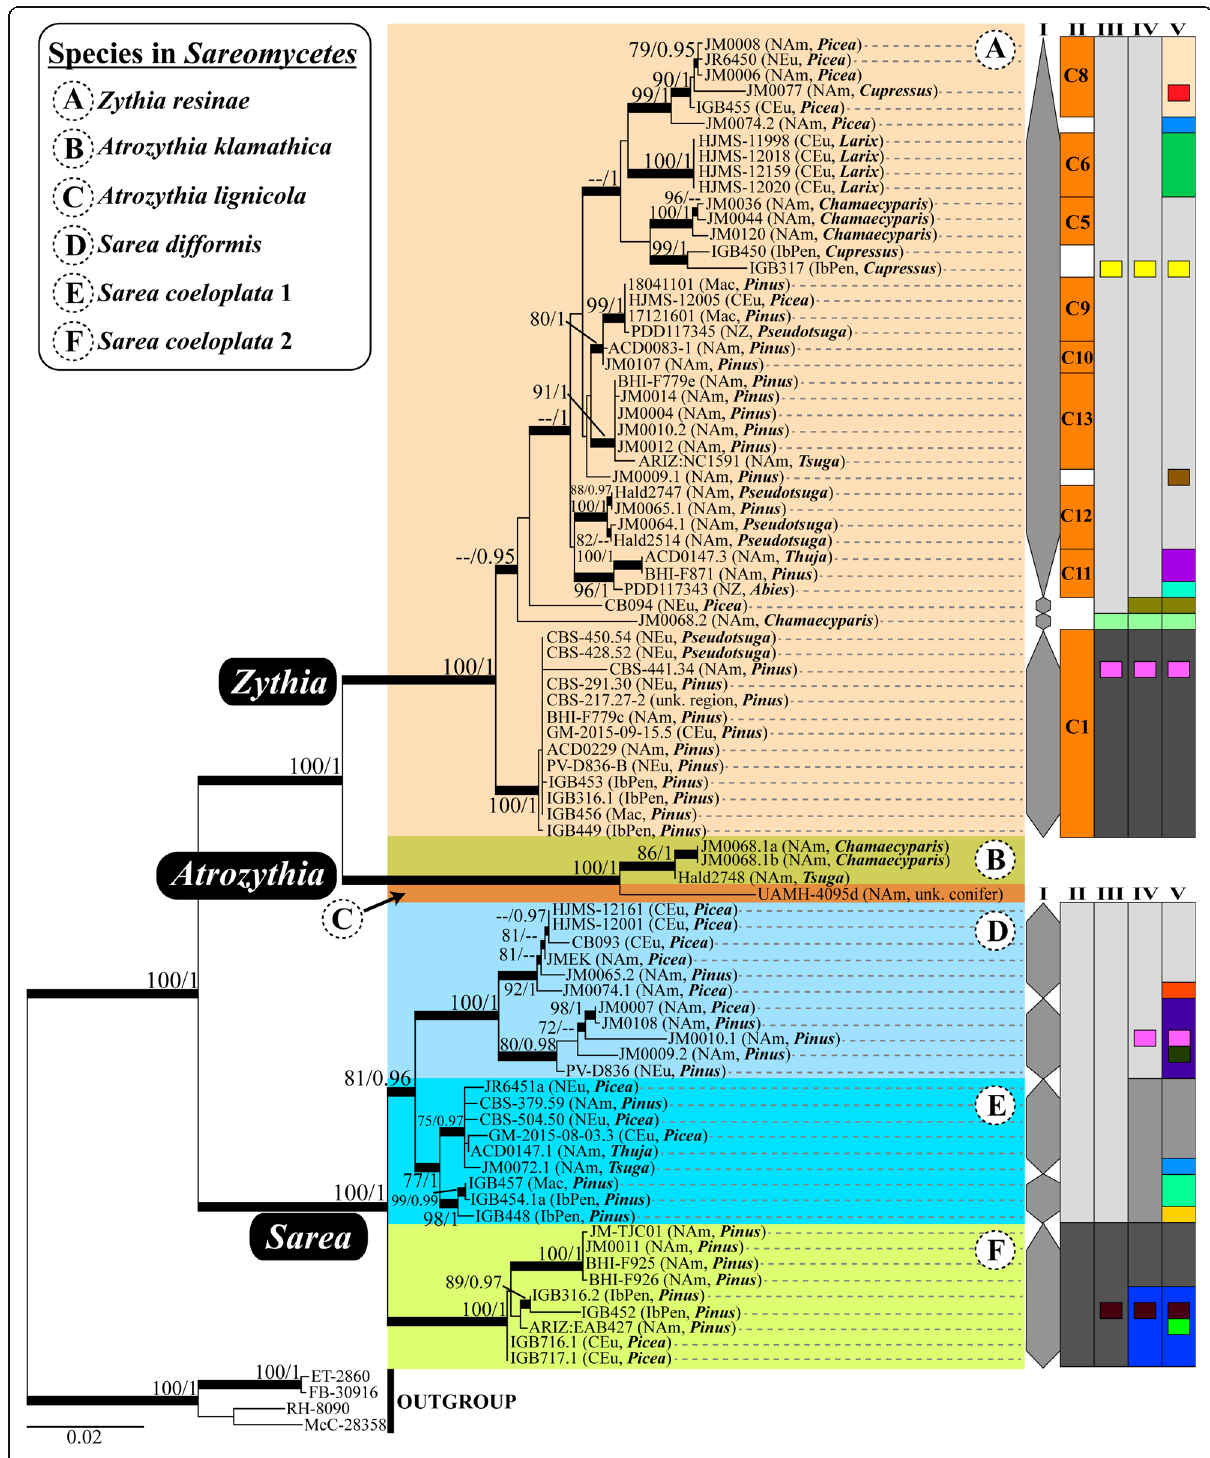
Fig. 4 (See legend on next